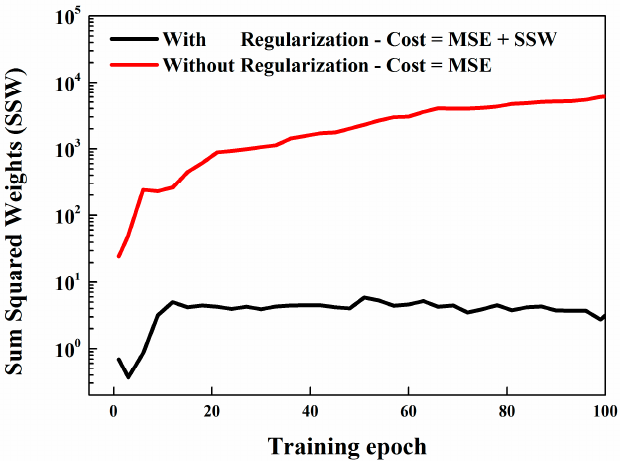
Figure 7. Trend of SSW along with training epoch, with and without regularization.